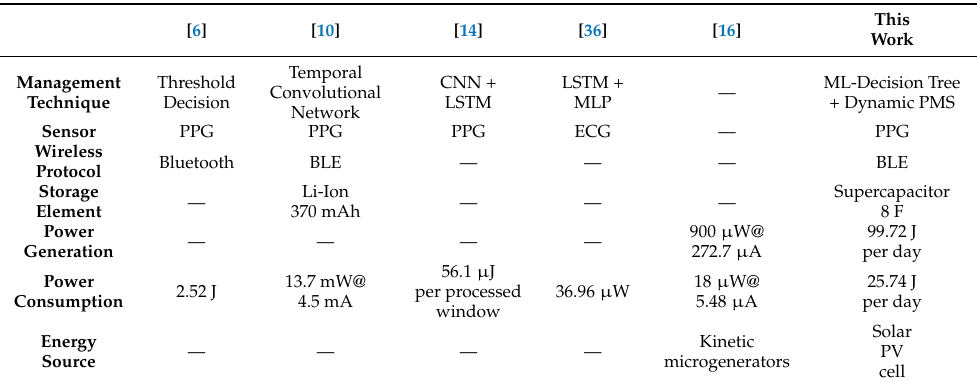
Table 1. Comparative analysis of the ML-DPMS